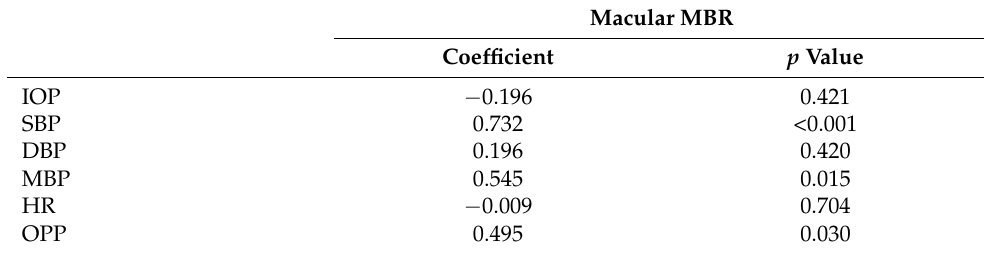
Table 2. Relationship between MBR and other studied